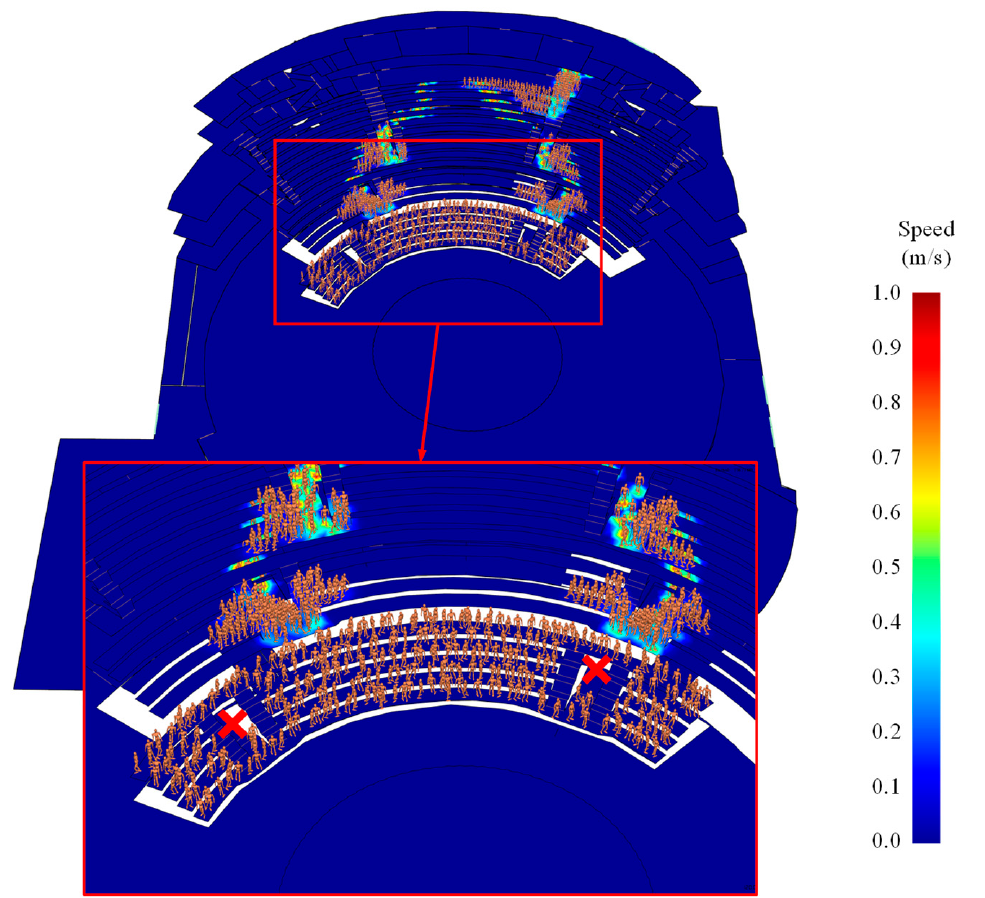
Figure 4. Distribution of audience when evacuation exits C1 and C2 of auditorium C are completely blocked.